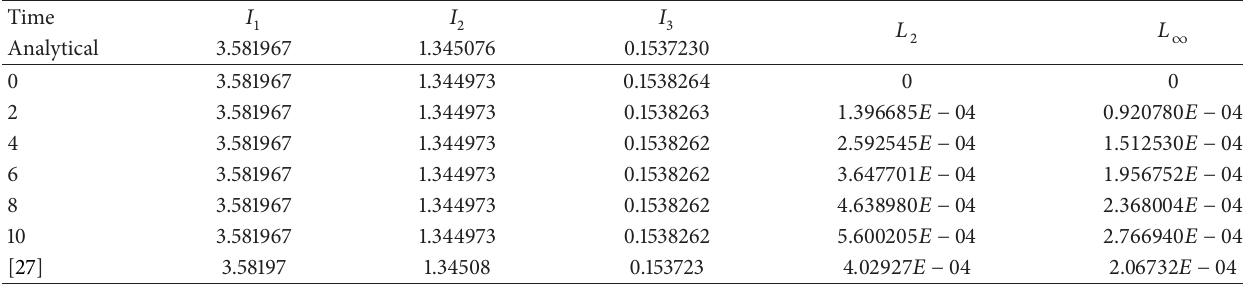
Table 5: Invariants and error norms for single solitary wave, 𝑐 = 0.3 , ℎ = 0.1 , 𝑘 = 0.01 , 𝑥 0 = 40 , and 0 ≤ 𝑥 ≤ 100 (using Runge-Kutta time